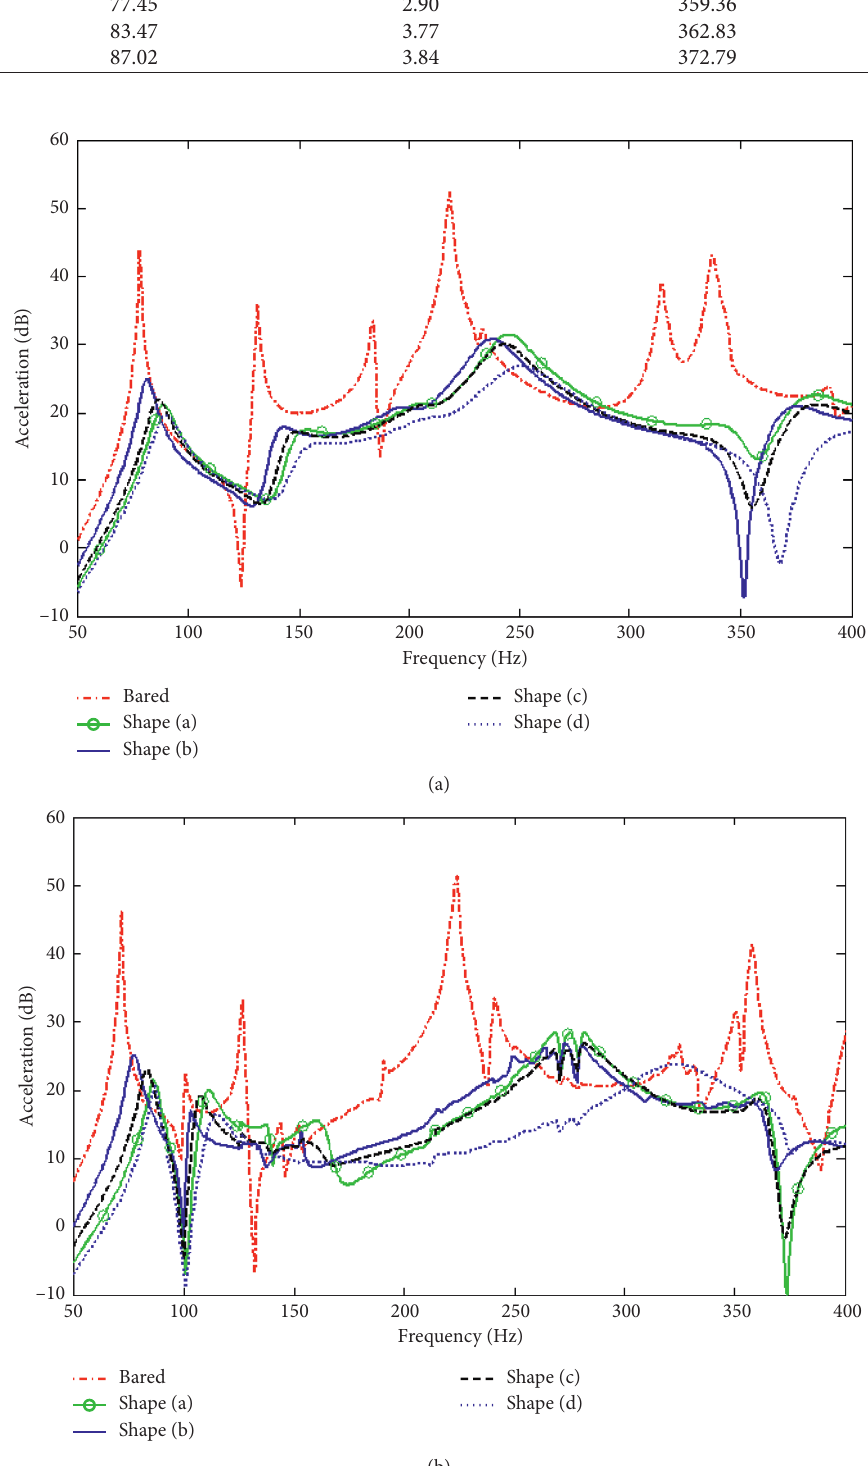
Figure 20: Frequency response functions between the exciting point (0.2m, 0.14m) and response point (0.12m, 0.08m): (a) Finite element method and (b) experimental